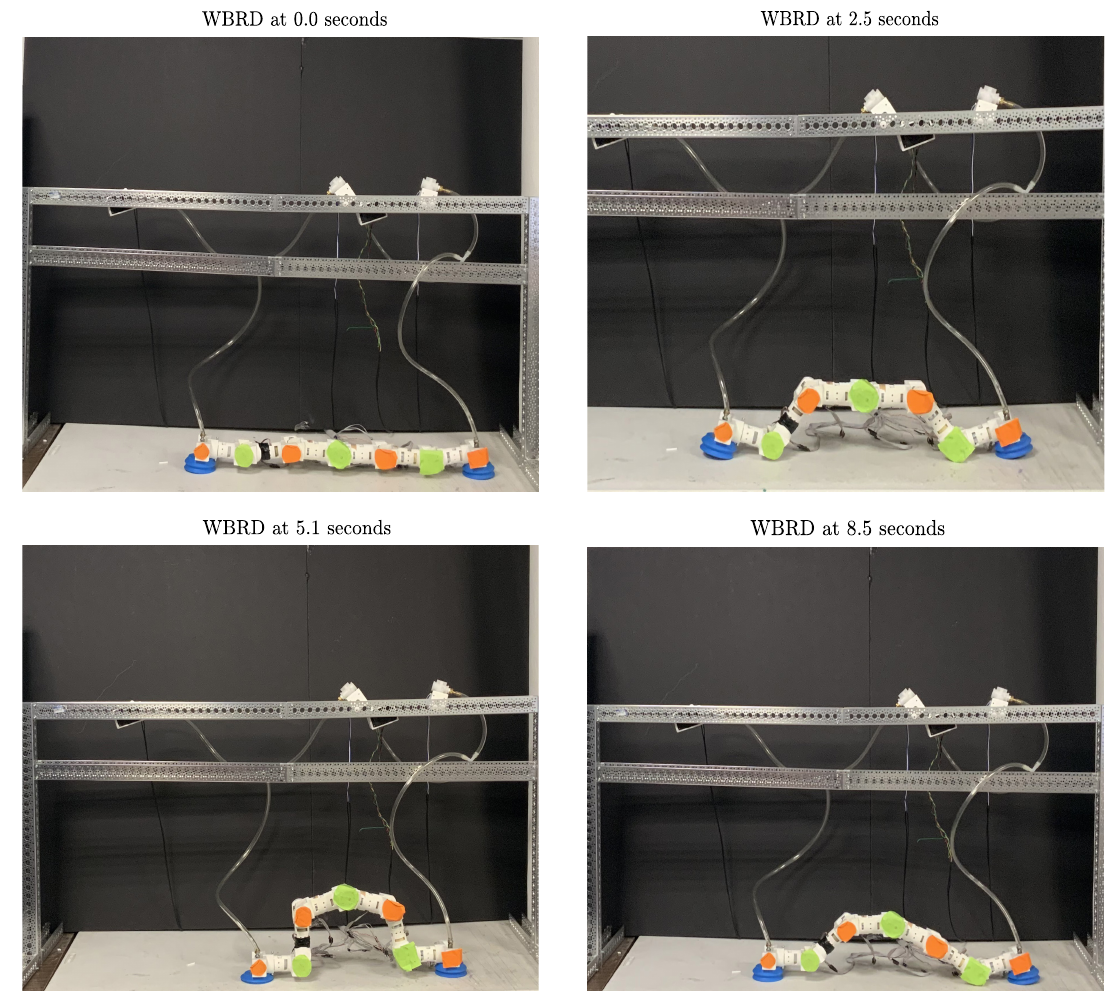
Figure 13. Experimental gait